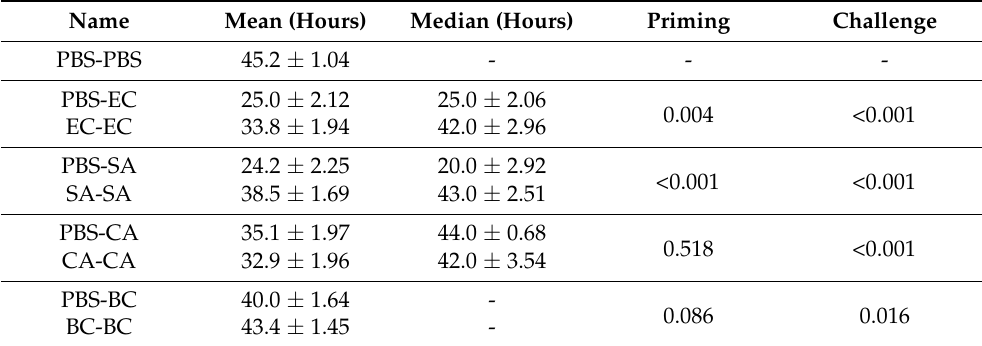
Table 2. Statistical measurements (mean and median) for the groups of T. molitor larvae challenged with four microorganisms after the priming procedures. The effects of priming and challenge among the groups were measured by Cox regression and the p -values, respectively.